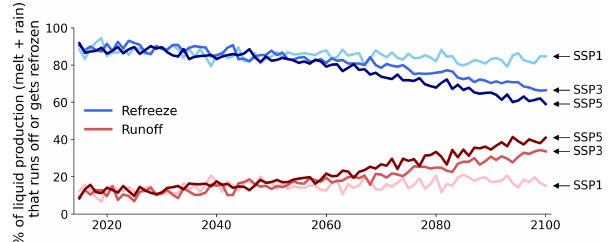
Figure A9. The percent of total AIS liquid production (melt + rainfall) that runs off (red) or gets refrozen (blue) in each future emission scenario.